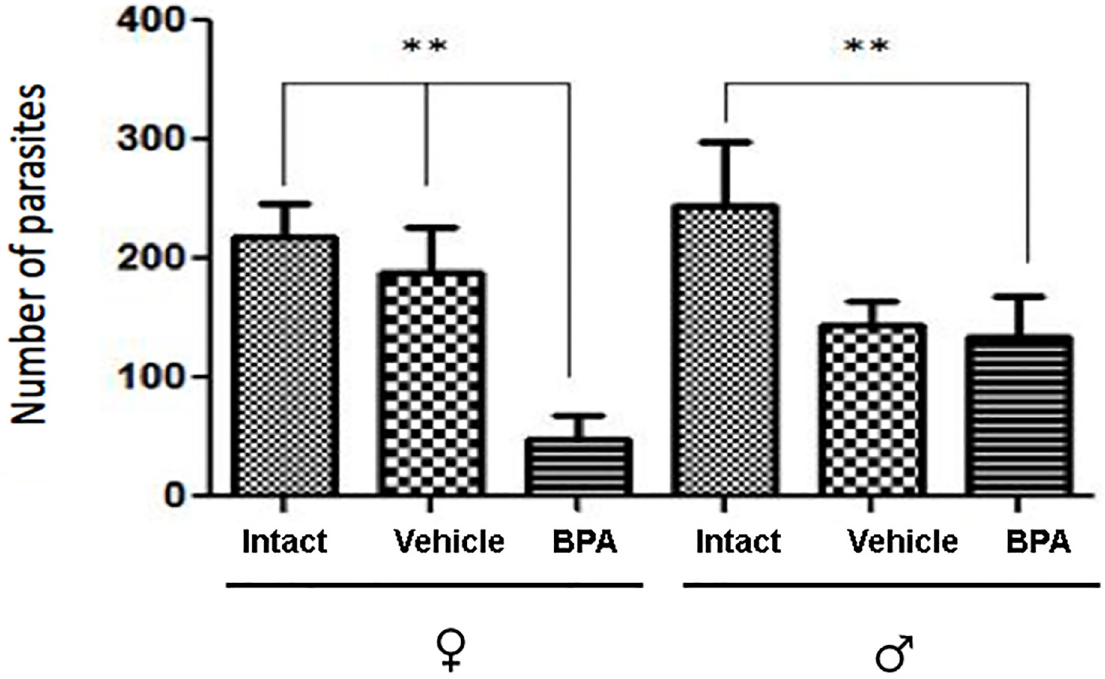
Fig 1. Parasitic burden in the small intestine. Treatment with BPA significantly decreased the number of parasites in male and female mice. The animals were infected with T . spiralis larvae and sacrificed after 5 days. Bars represent female and male mice from the three infected groups: control infected (C-I), vehicle infected (VH-I) and BPA infected (BPA-I). Data are shown as mean ± standard deviation. ��� P < 0.05.